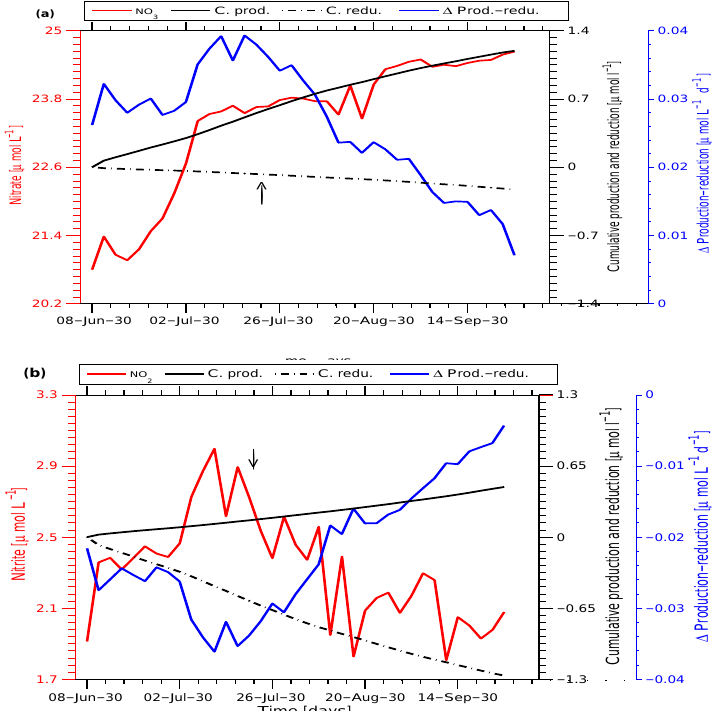
Figure 7. (a) Time evolution of cumulative production (full black line, µmolL − 1 ), cumulative reduction (dashed black line, µmolL − 1 ), production-reduction difference (blue line, µmolL − 1 ) and available nitrate (red line, µmolL − 1 ) within the subsurface layer of the eddy A sim . (b) The same as (a) but for nitrite. The concentration and fluxes in (a, b) correspond to averaged quantities between 100 and 200m layer within the eddy structure. Arrow indicates the time when the sections in Fig. 4 were made.